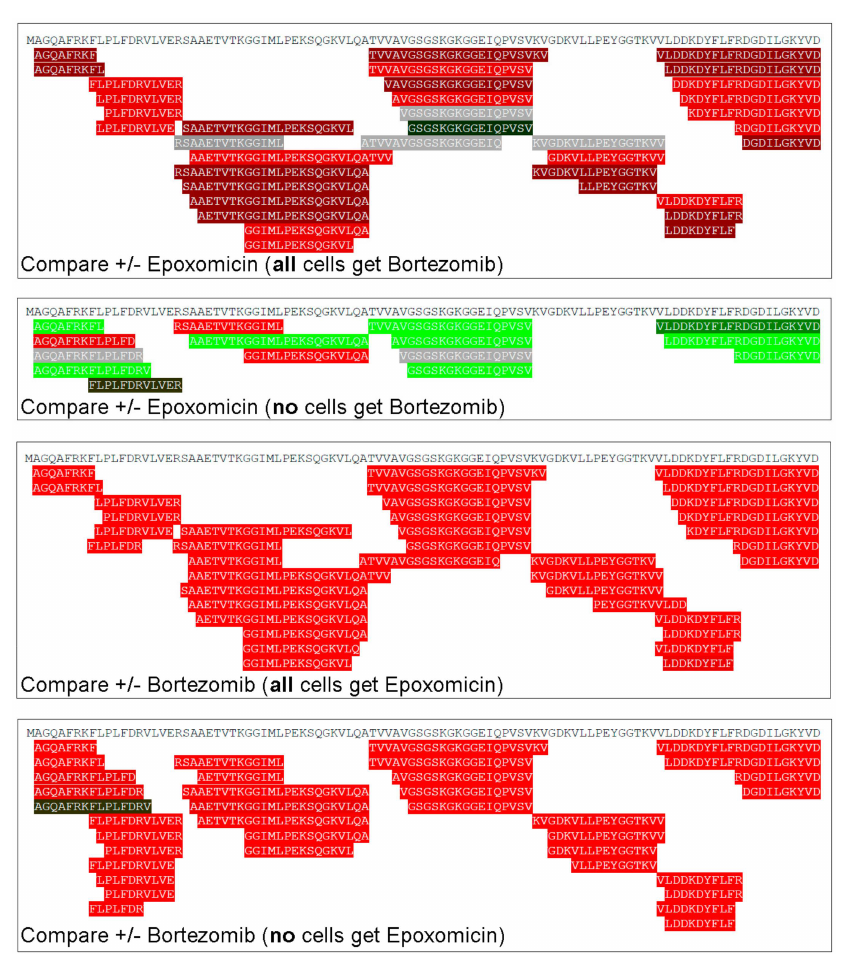
Figure 6. Relative levels of all peptides derived from heat shock 10-kDa protein 1 in HEK293T cells. Cells were treated as described in Figure 4 and the ratio for each peptide was color-coded using the scheme shown in Figure 2, with green representing decreases, red representing increases, and grey representing no substantial